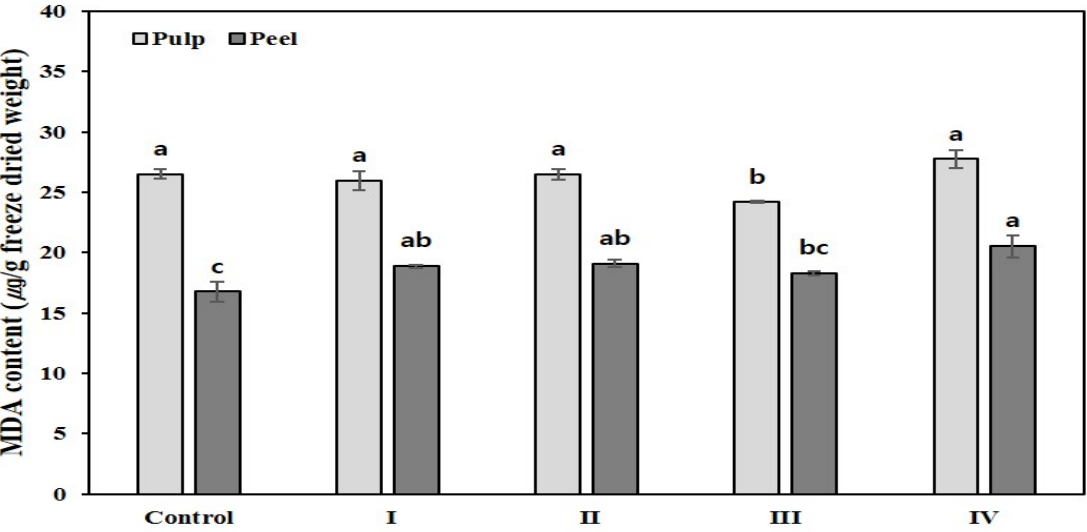
Figure 4. Malondialdehyde (MDA) contents ( μ g/g freeze-dried weight) according to the degree of sunburn in fruits of Satsuma mandarin. The values representing different letters are statistically significant ( p < 0.05).